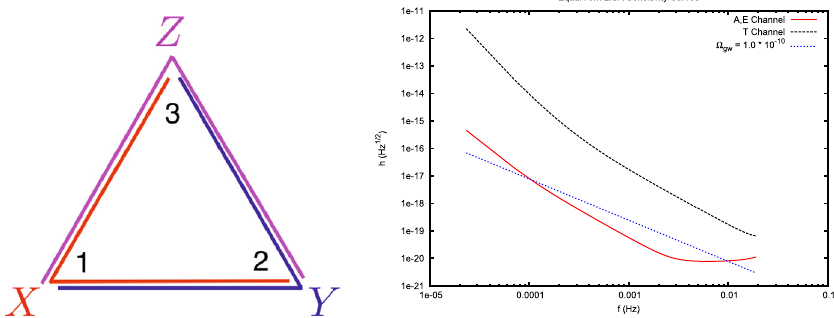
Fig.78 Panel a showsthegeometryofaLISA-likespaceinterferometerandthelaserpathsforthesynthetic Michelsoninterferometers X , Y , Z .Panel b showssensitivitycurvesforthe A , E , T interferometryvariables compared to a scale-invariant background, Ω gw ( f ) = Ω 0 = const, with Ω 0 = 10 − 10 . The Sagnac-like T channel is far less sensitive than the Michelson-like A , E channels, and can be used to measure the instrumental noise levels. (Panel b is adapted from Adams and Cornish